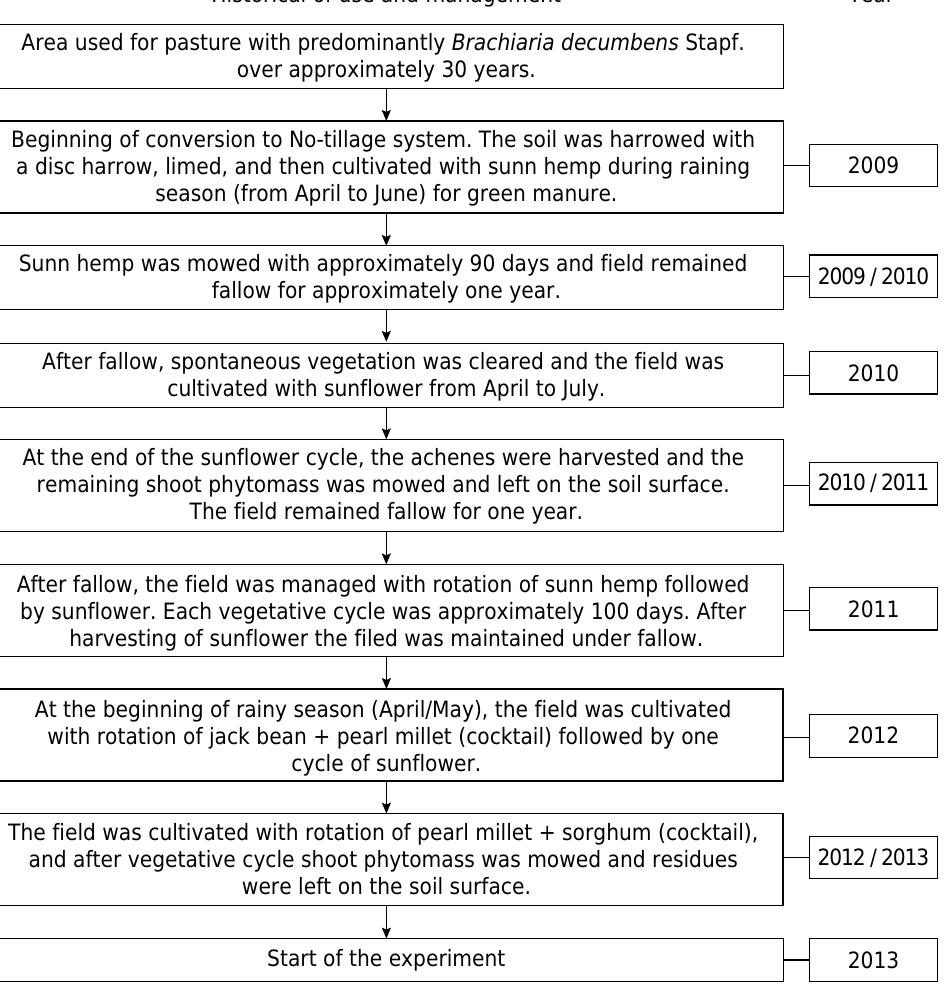
Figure 2. Historical of use and management of the experimental